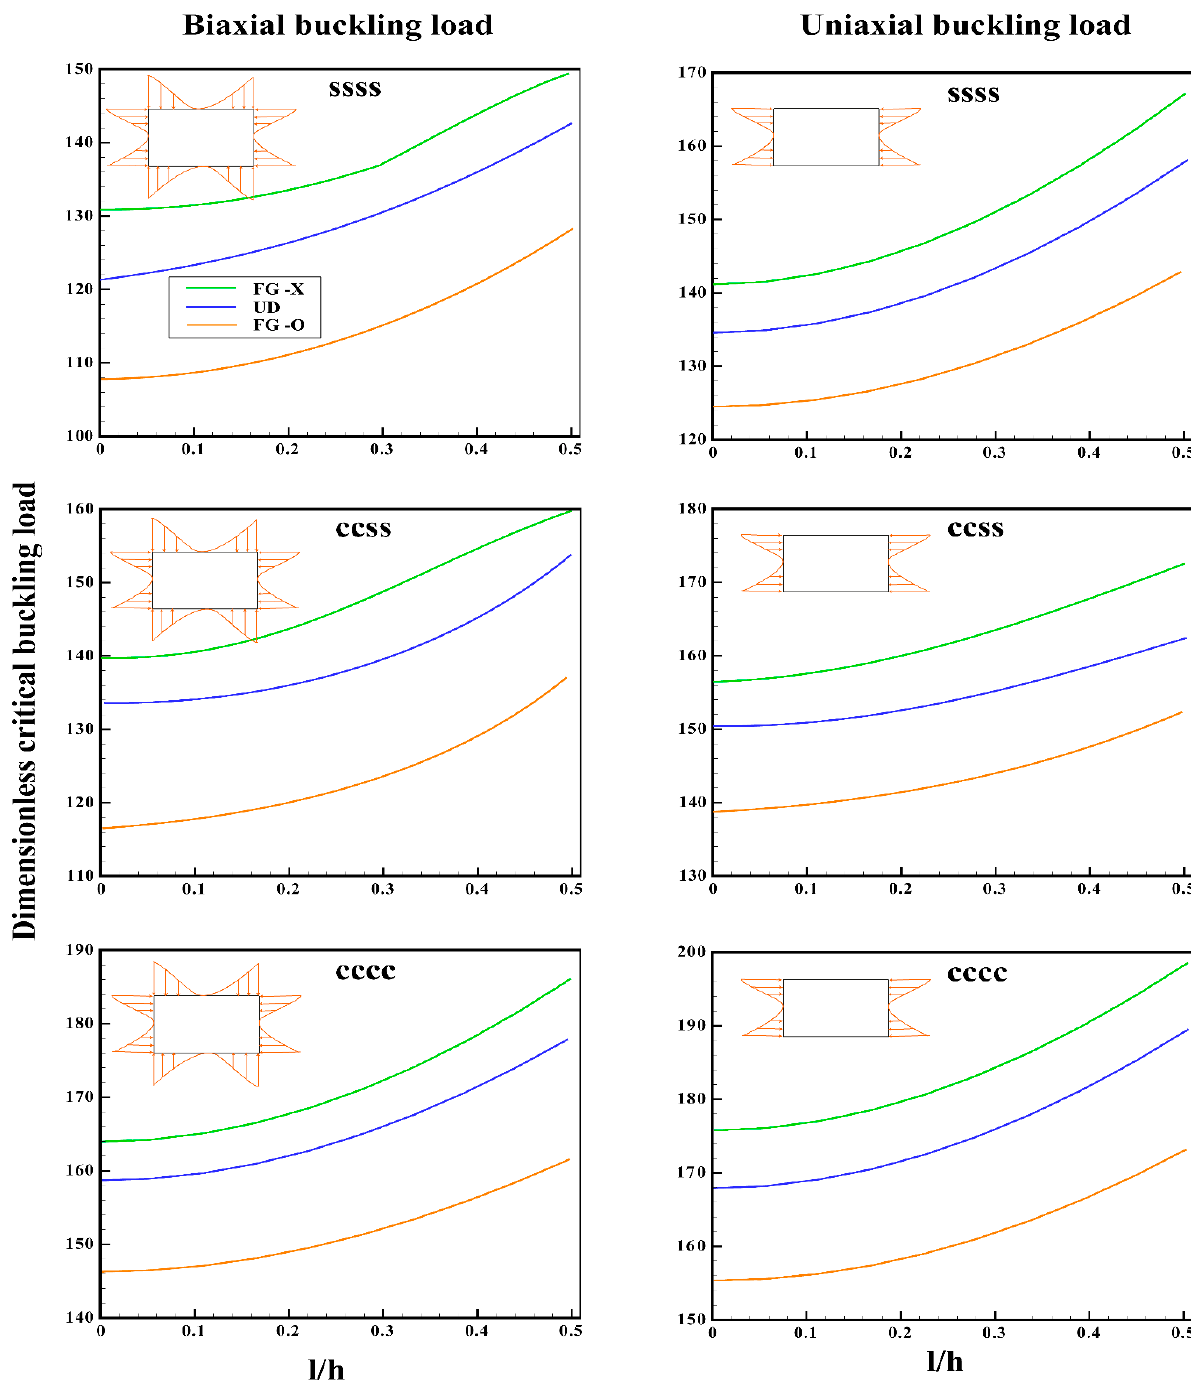
Figure 8. The effects of the CNT distributions on the uniaxial and biaxial buckling loads of the FG- CNTRC microplate against the material length scale parameter to thickness ratio (reverse sinusoidal edge compressive load).